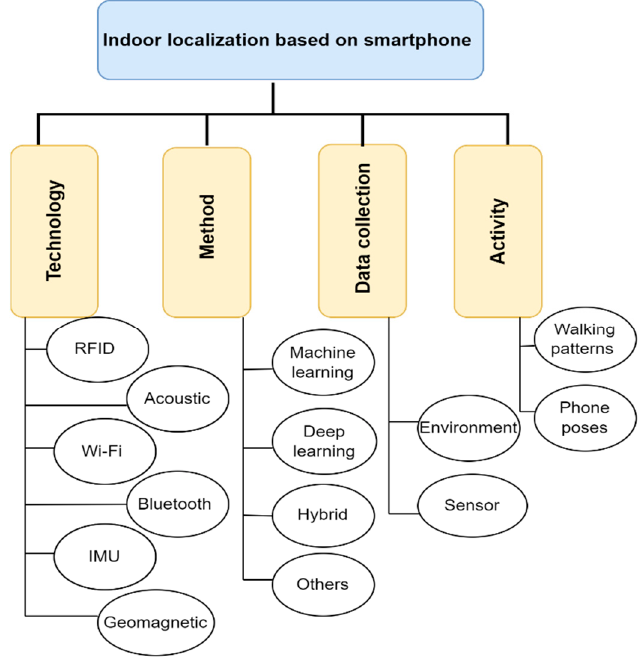
Figure 3. Classi fi cation of articles selection. Figure 3. Classification of articles